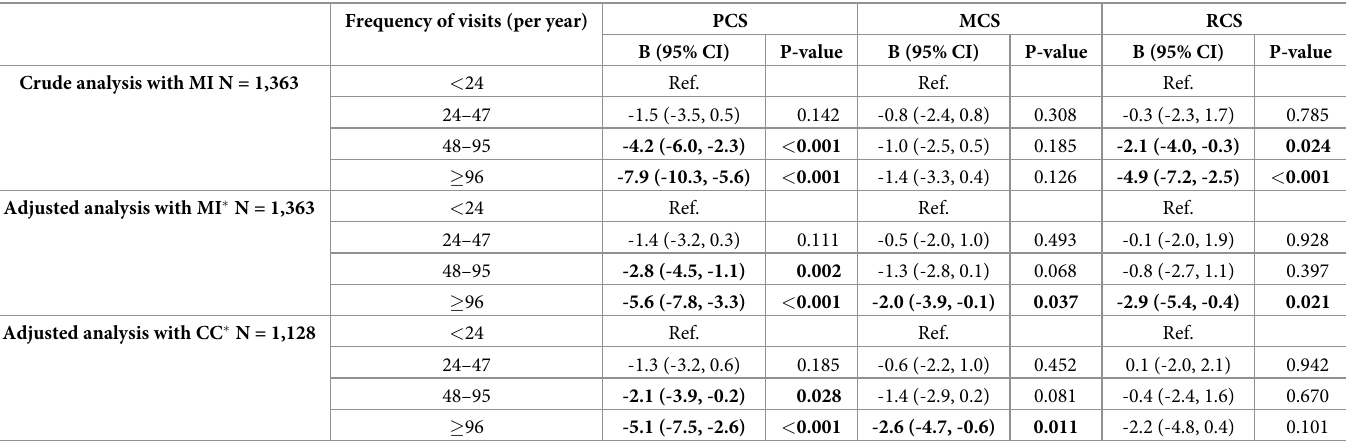
Table 3. Association between frequency of acupuncture clinic visits and subjective health